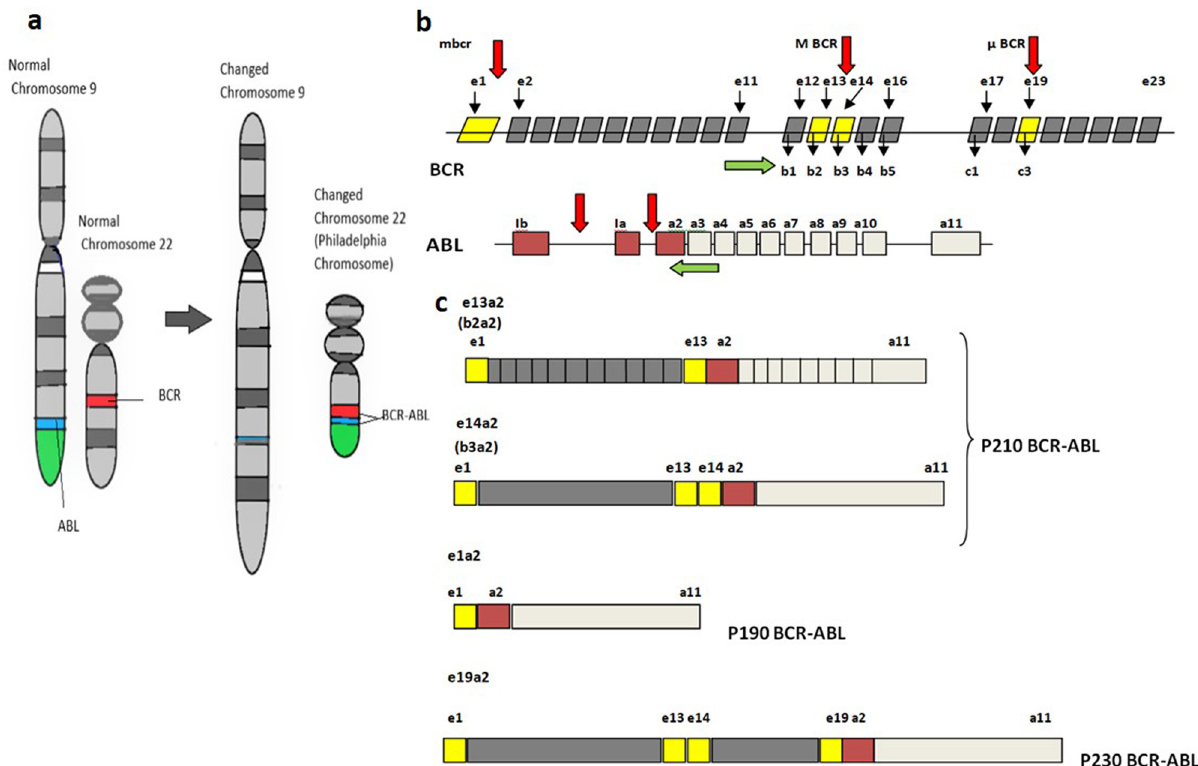
Figure 1: ( a ) Schematic diagram of the normal structure of chromosome 9 and 22 and translocation between chromosome 9 and 22, resulting in Philadelphia chromosome. ( b ) Schematic representation of the molecular structure of BCR and ABL genes. Red arrows indicate breakpoints in both genes. Green arrows show the placement of forward and reverse primer on the exons of BCR and ABL for detection of di ff erent transcripts by RT - PCR. ( c ) Schematic diagram of the structure of chimeric mRNA transcribed from di ff erent breakpoints of BCR – ABL fusion